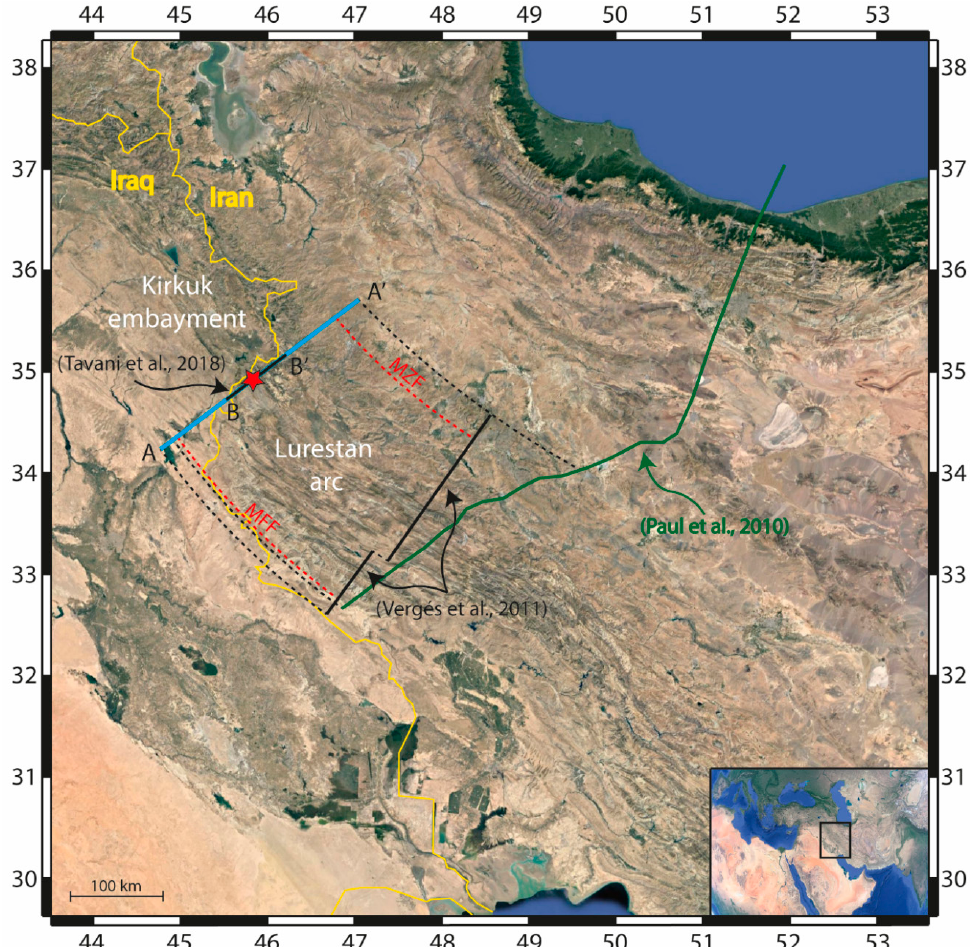
Figure 2. Satellite image of the study area. The yellow line represents the political boundary between Iraq and Iran. Green line shows the trace of the composite profile “Zagros03” and “Alborz03” by Paul et al. [6], providing the Moho depth used in this research. Black lines show traces of published geological sections. Red and black dashed lines are the guidelines used to project sections and faults on our model (blue line A–A’). Red star is the epicentral position of the seismic event of 12 November 2017 (M w = 7.3) [3].